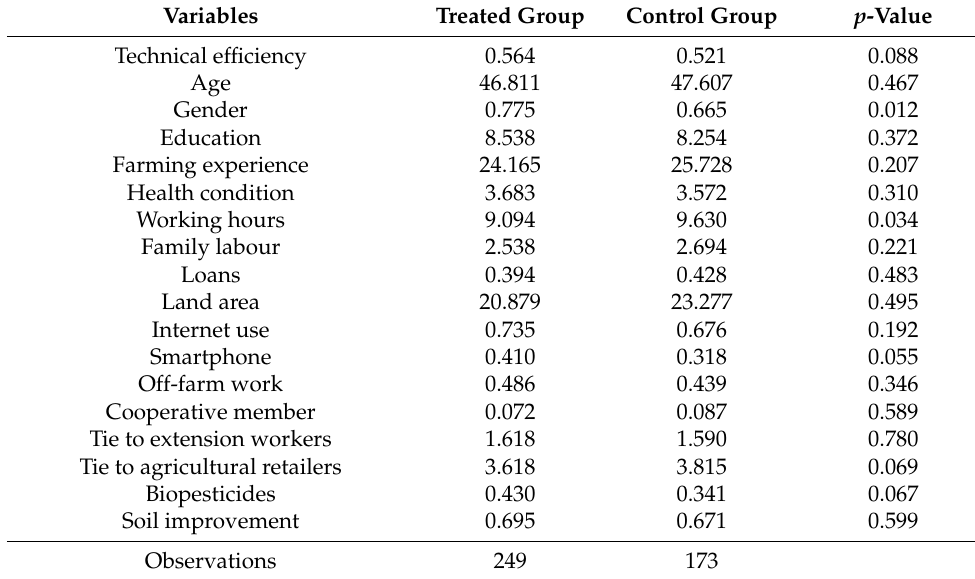
Table 4. Difference of characteristics between participants and